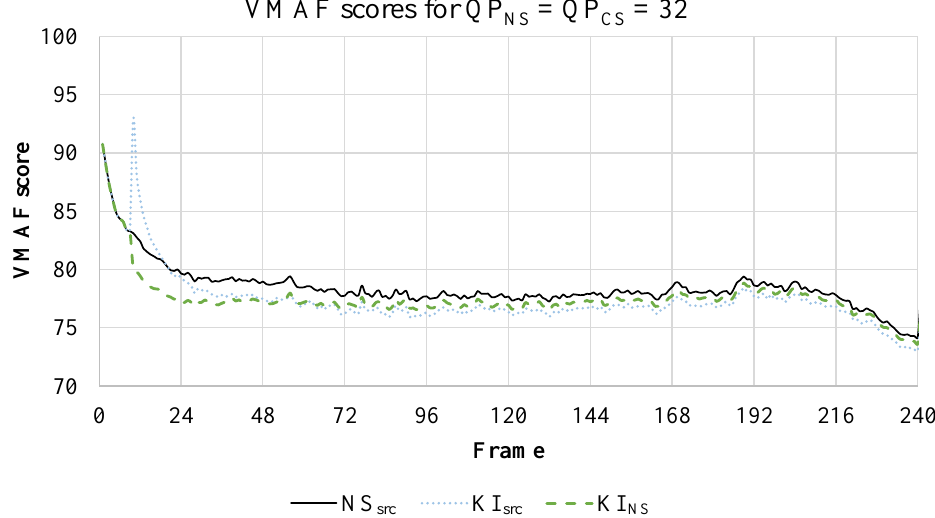
Figure 5. VMAF scores of the ParkScene -sequence, encoded with QP NS = QP CS = 32. It takes several frames for the quality of KI src to drop below the quality of NS src and KI NS